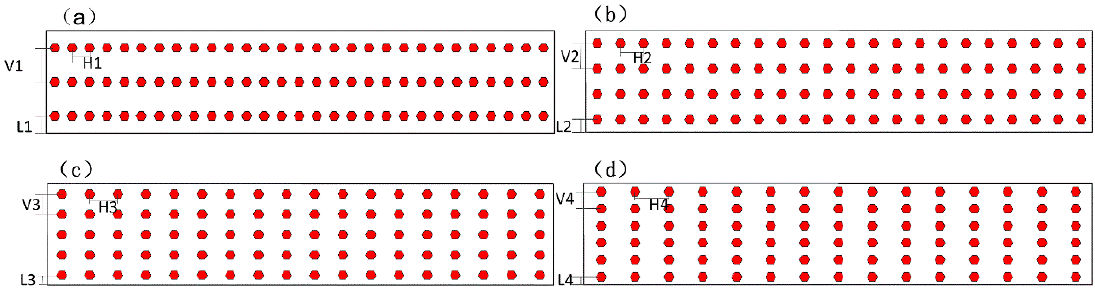
Figure 11. Different order distributions of diamonds in the segment: three rows ( a ), four rows ( b ), five rows ( c ), and six rows ( d ).